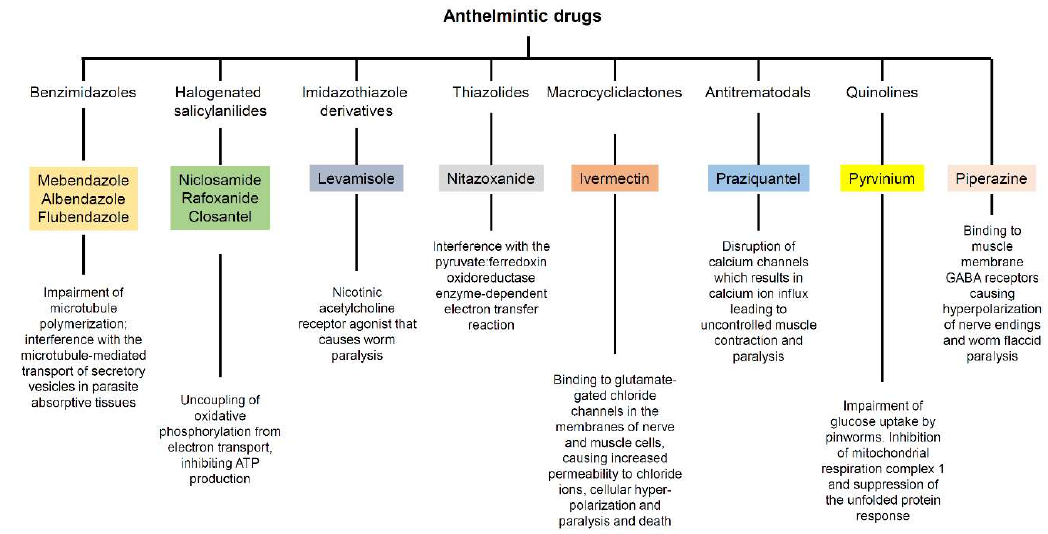
Figure 1. Class and mechanism of action against parasites of the anthelmintic drugs reviewed herein.